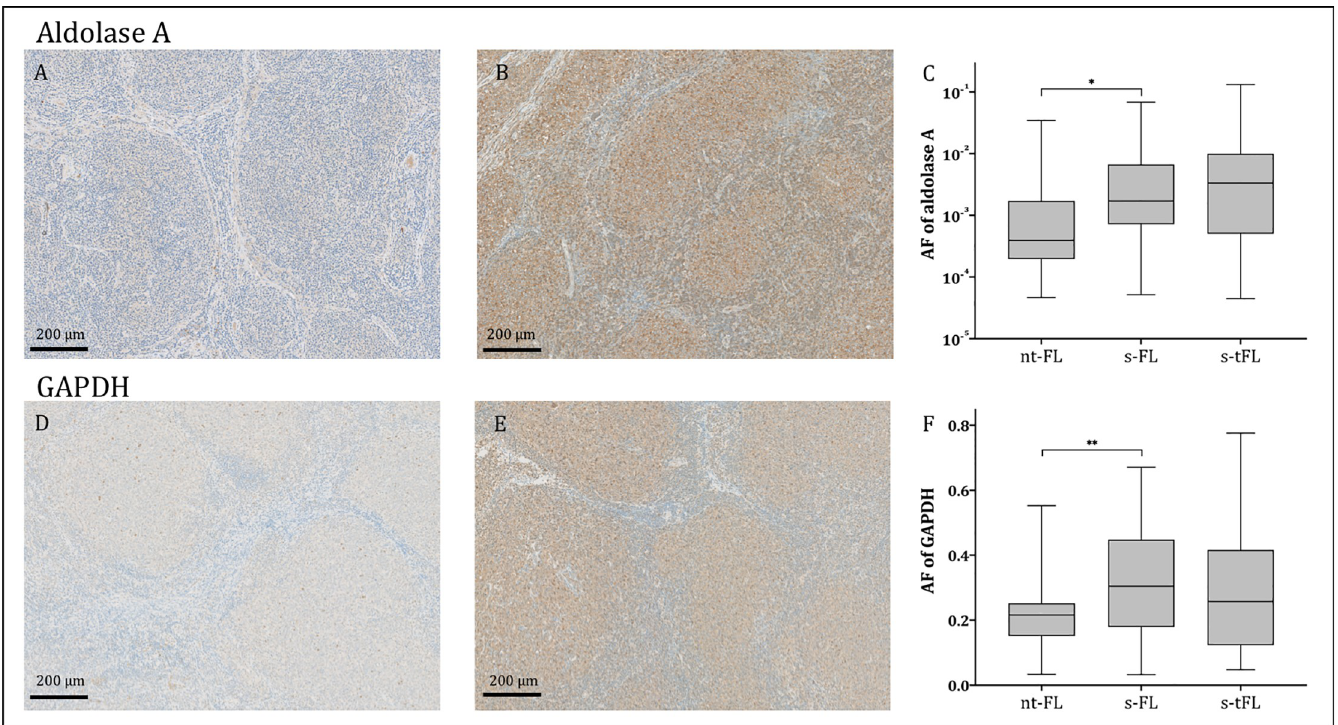
Fig 1. Predictive biomarker expression levels. Representative images of tumor tissues stained for aldolase A (A-B) and GAPDH (D-E). A and D show tumor tissue from patients with no subsequent transformation (nt-FL), while images B and E show tumor tissue from the initial FL diagnosis, from a patient with subsequent transformation (s-FL). Area fractions of strong intensity aldolase A staining (C) and GAPDH (F) were significantly higher in FL diagnostic samples of patients with subsequent transformation (s-FL) compared with patients without (nt-FL); � p < 0.001, �� p < 0.01. Two patients were not eligible for GAPDH IHC analysis and thus 39 nt-FL patients remained in this group (F). No significant difference in aldolase A and GAPDH expression was observed between FL diagnosis (s-FL samples) and time of transformation (s-tFL samples) (C and F). AF, area fraction; immunohistochemistry; FL, follicular lymphoma; FLIPI, follicular lymphoma international prognostic index; GAPDH, glyceraldehyde-3-phosphate dehydrogenase; HT, histological transformation; LDH, lactate dehydrogenase; PFS, progression free survival; TFS, transformation free survival.